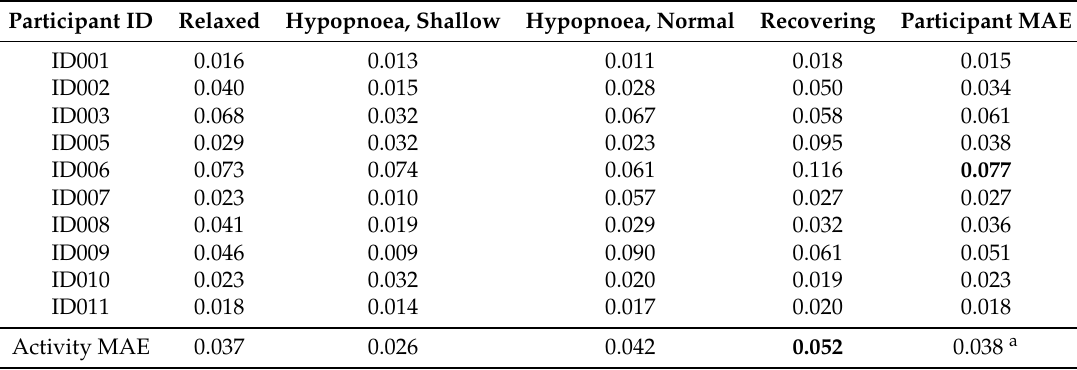
Table 3. Mean absolute error (MAE, s) for interbeat intervals with respect to activity and